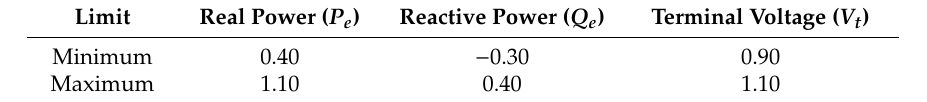
Table 1. Ranges of the operating condition in per unit (pu) for the selected power system networks.